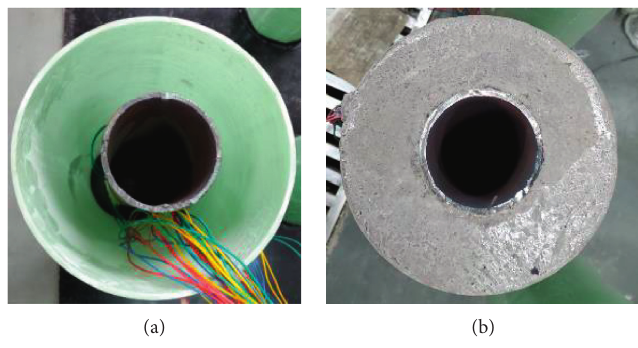
Figure 4: Section form of the specimen. Table 1: Chart of experimental parameters and results.